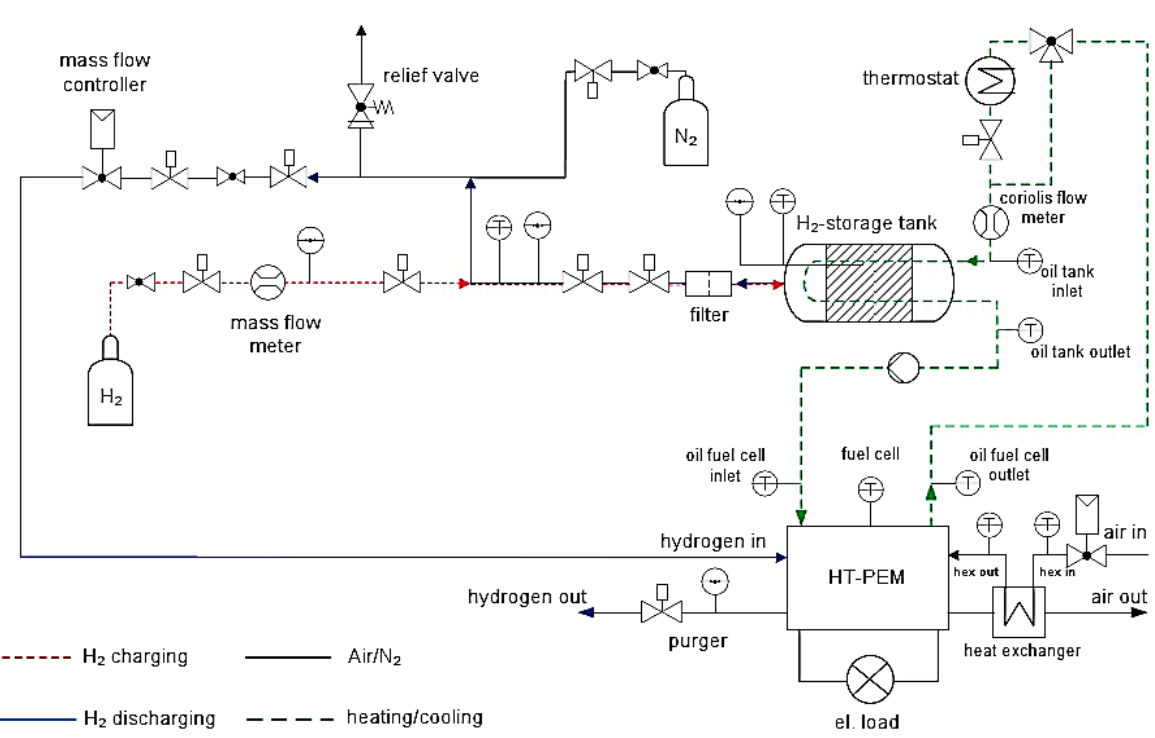
Figure 2. Sketch of the test rig where the storage tank is coupled with high temperature proton exchange membrane (HT-PEM) fuel cell. Reprinted with permission from reference [37]. Copyright 2011 Wiley.